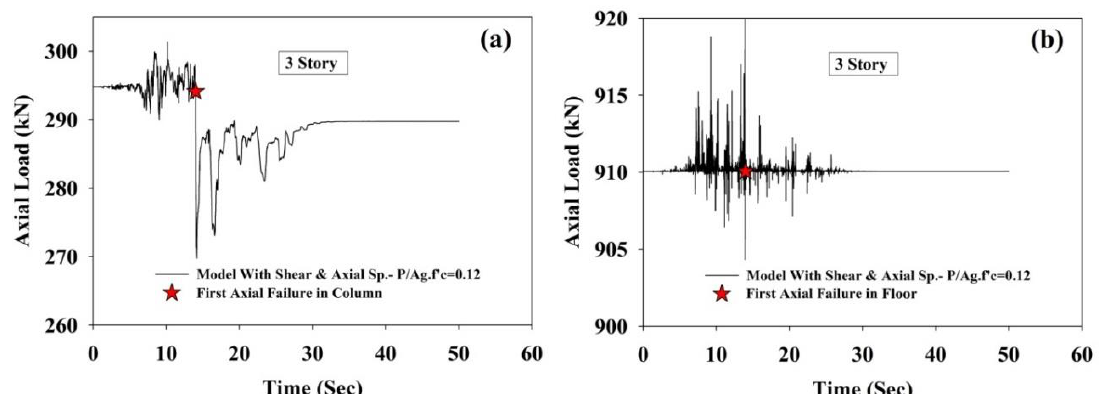
Fig. 13. Axial load versus time in 3-Story model, (a) in a column suffered axial failure, (b) in the floor including the column which suffered axial